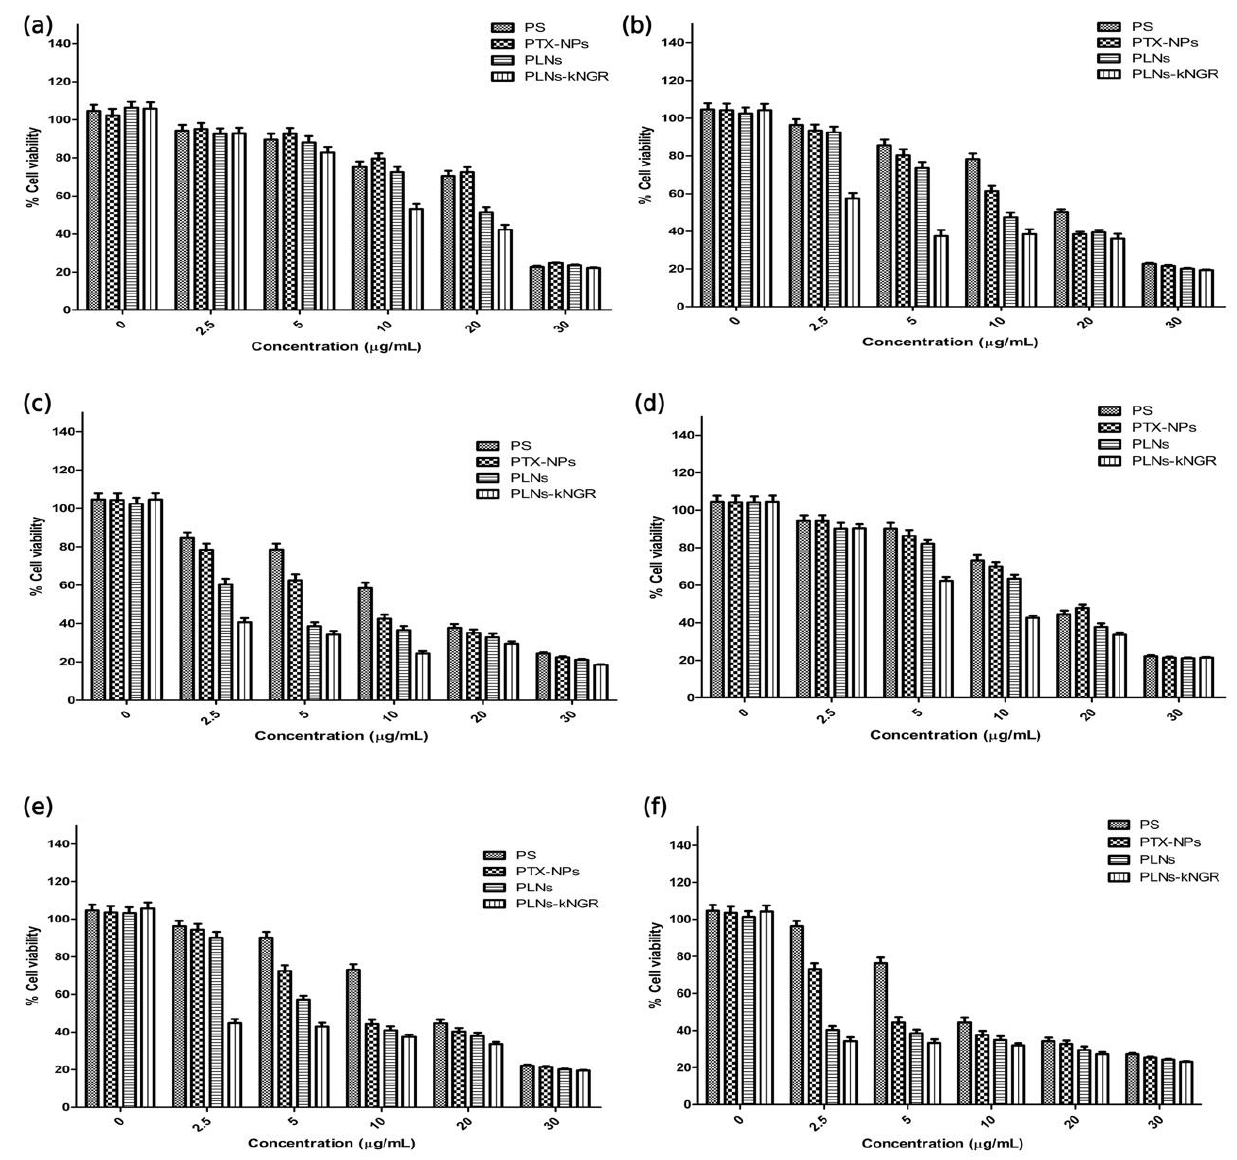
Figure 5. In-Vitro cytotoxicity at different concentration of various PTX-based formulations as free PTX solution (PS) PTX-based Nanoparticles (PTX-NPs), unconjugated polymer–lipid hybrid nanoparticles (PLNs) and kNGR-conjugated polymer–lipid hybrid nanoparticles (PLNs-kNGR) of PTX against different cells ( a ) 24 h ( b ) 48 h ( c ) 72 h and in HT-1080 cells ( d ) 24 h ( e ) 48 h ( f ) 72 h in HUVEC cells. Table 2. IC 50 value of various PTX-loaded formulations on HUVEC and HT-1080 cell lines following 24, 48 and 72 h treatment, respectively.